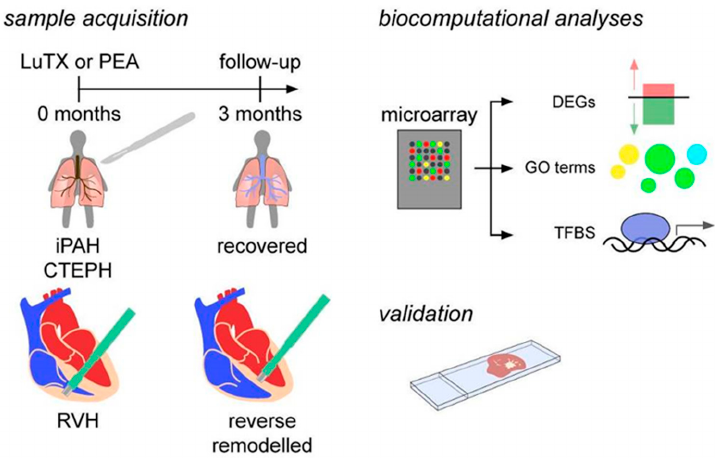
Figure 1. Study design. Cardiac biopsies were acquired intraoperatively and 3 months after surgery. Transcriptional signatures were investigated using a microarray and further biocomputational anal- yses. Lastly, results were validated using immunocytochemistry. CTEPH, chronic thromboembolic pulmonary hypertension; DEGs, differentially expressed genes; GO, gene ontology; iPAH, idio- pathic pulmonary arterial hypertension; LuTX, lung transplantation; PEA, pulmonary endarterec- tomy; RVH, right ventricular hypertrophy; TFBS, transcription factor binding site. 2. Materials and Methods 2.1. Study Population This study was designed as a prospective, longitudinal, cross-sectional cohort study in 2013. All patients were diagnosed as recommended by applicable guidelines [4,34]. PEA and LuTX surgery were carried out at a single European thoracic surgery center (De- partment of Thoracic Surgery, Medical University of Vienna, Vienna, Austria). The diag- nosis of CTEPH and indication for PEA surgery were performed by teams of specialists. All patients with CTEPH were classified according to the intraoperative classification sys- tem [35]. Preoperative assessments included computed tomography of the chest, right heart catheterization with hemodynamic measurements and conventional pulmonary an- giography, transthoracic echocardiography, and pulmonary function studies in each pa- tient. Evaluation and listing of iPAH patients for lung transplantation was performed by a multidisciplinary lung transplant team of the Medical University of Vienna according to applicable guidelines [4,34]. 2.2. Ethics Statement Ethical approval was granted by the Institutional Ethics Committee of the Medical University of Vienna, Vienna, Austria (1805/2013). This study was performed in accord- ance with the Declaration of Helsinki and applicable local regulations. All donors pro- vided written informed consent. 2.3. Sample Acquisition For transcriptional analyses, 4 patients with iPAH undergoing bilateral LuTX on cen- tral extracorporeal membrane oxygenation (ECMO) support (Table 1) and 4 patients with CTEPH undergoing PEA on cardiopulmonary bypass in deep hypothermia and circula- tory arrest (Table 2) were enrolled (Figure 1). Endomyocardial biopsies (EMB) were ob- tained intraoperatively and 3 months after surgery. Intraoperative myocardial biopsies (1